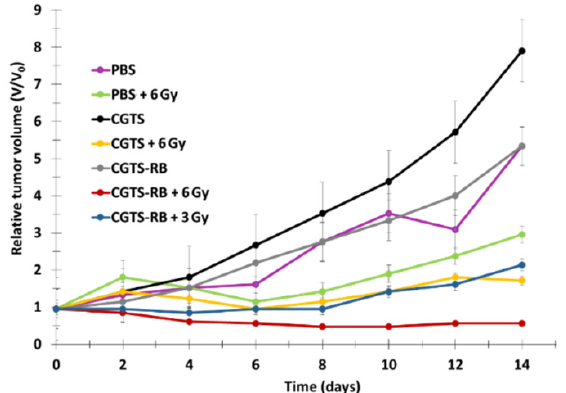
Figure 41. Relative tumor volume under different treatment conditions (2 mg/mL, 200 µ L, X-ray irradiation (160 kV, 25 µ A, 1 Gy/min)). Adapted from Ahmad et al.